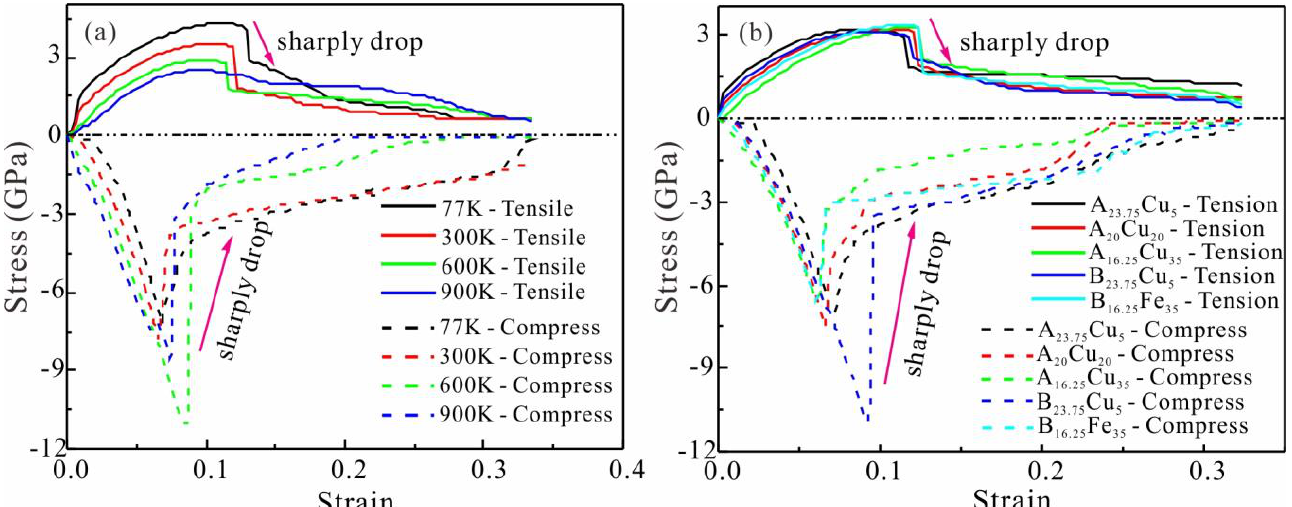
Figure 5. ( a ) Stress-strain curves of FeNiCrCoCu HEAs with unequal atomic ratio under tensile and compressive loads at different temperatures. ( b ) Stress-strain curves of FeNiCrCoCu HEAs with unequal atomic ratio under different component and proportions, where A x is Fe x Ni x Co x Cr x ( x = 23.75, 20, 16.25) and B y is Ni y Co y Cr y Cu y ( y = 23.75, 16.25).